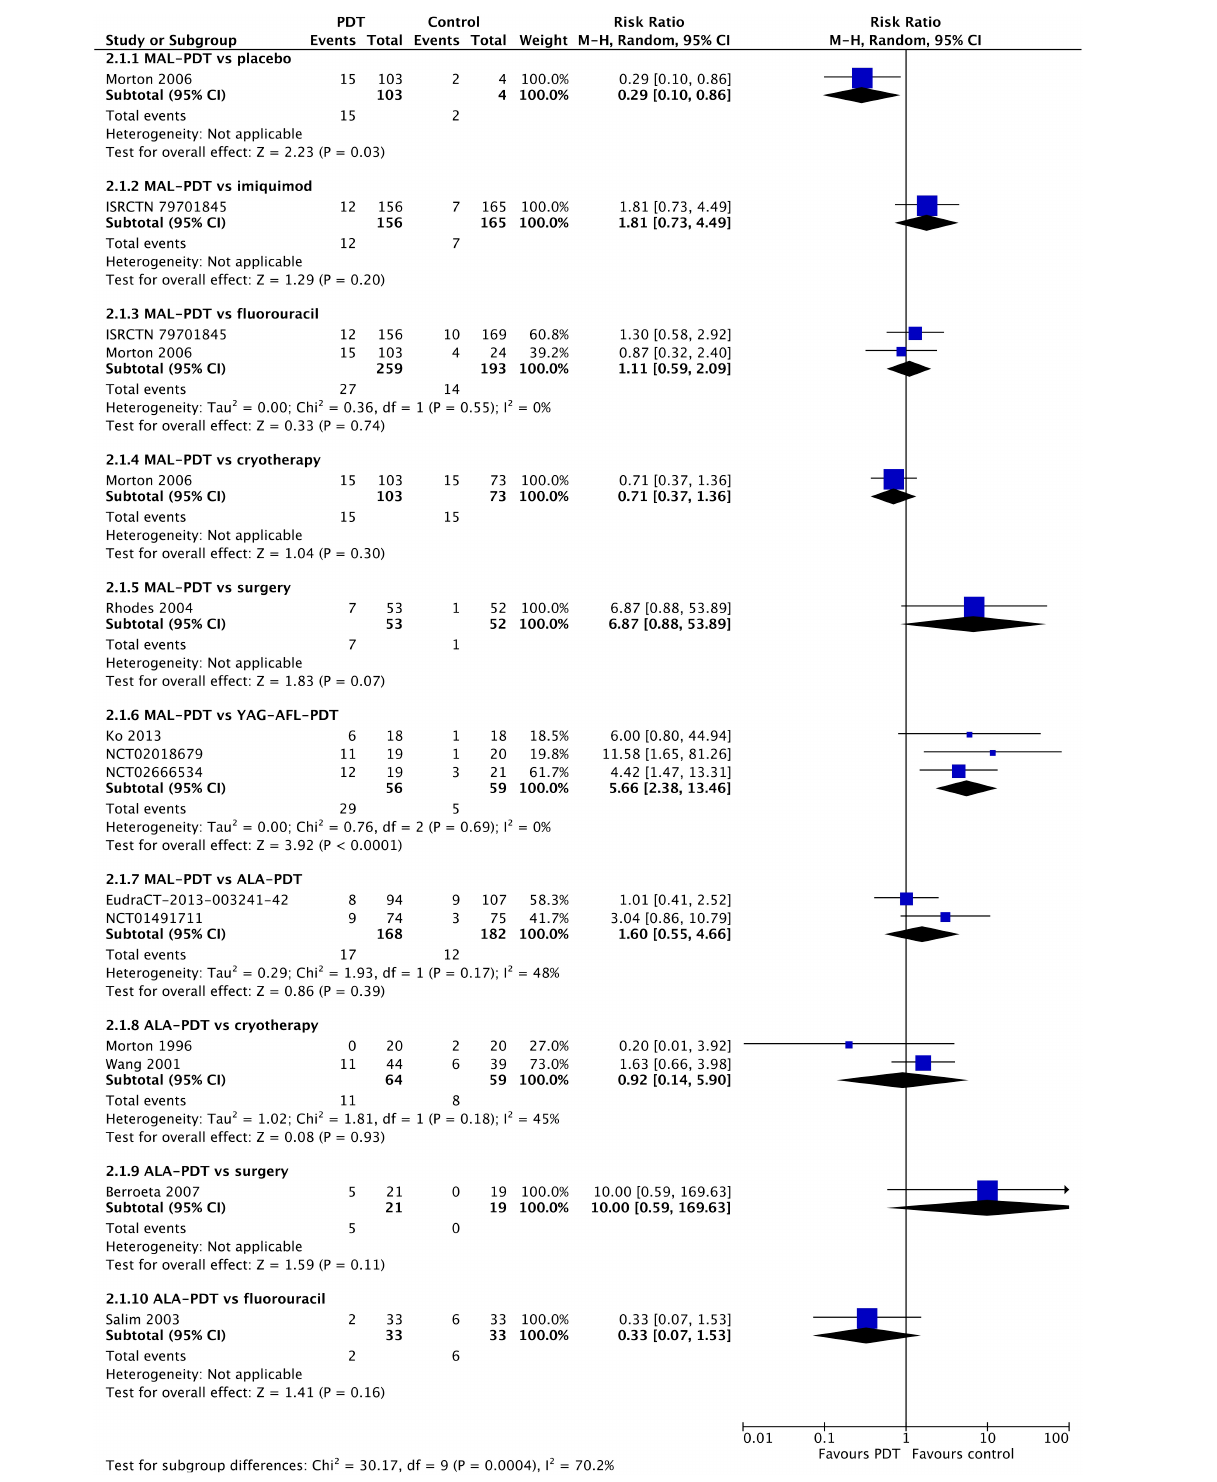
FIGURE4 Meta-analysis of the risk of recurrence at 12 months post-treatment by comparator. Data are risk ratios with 95% confidence intervals.